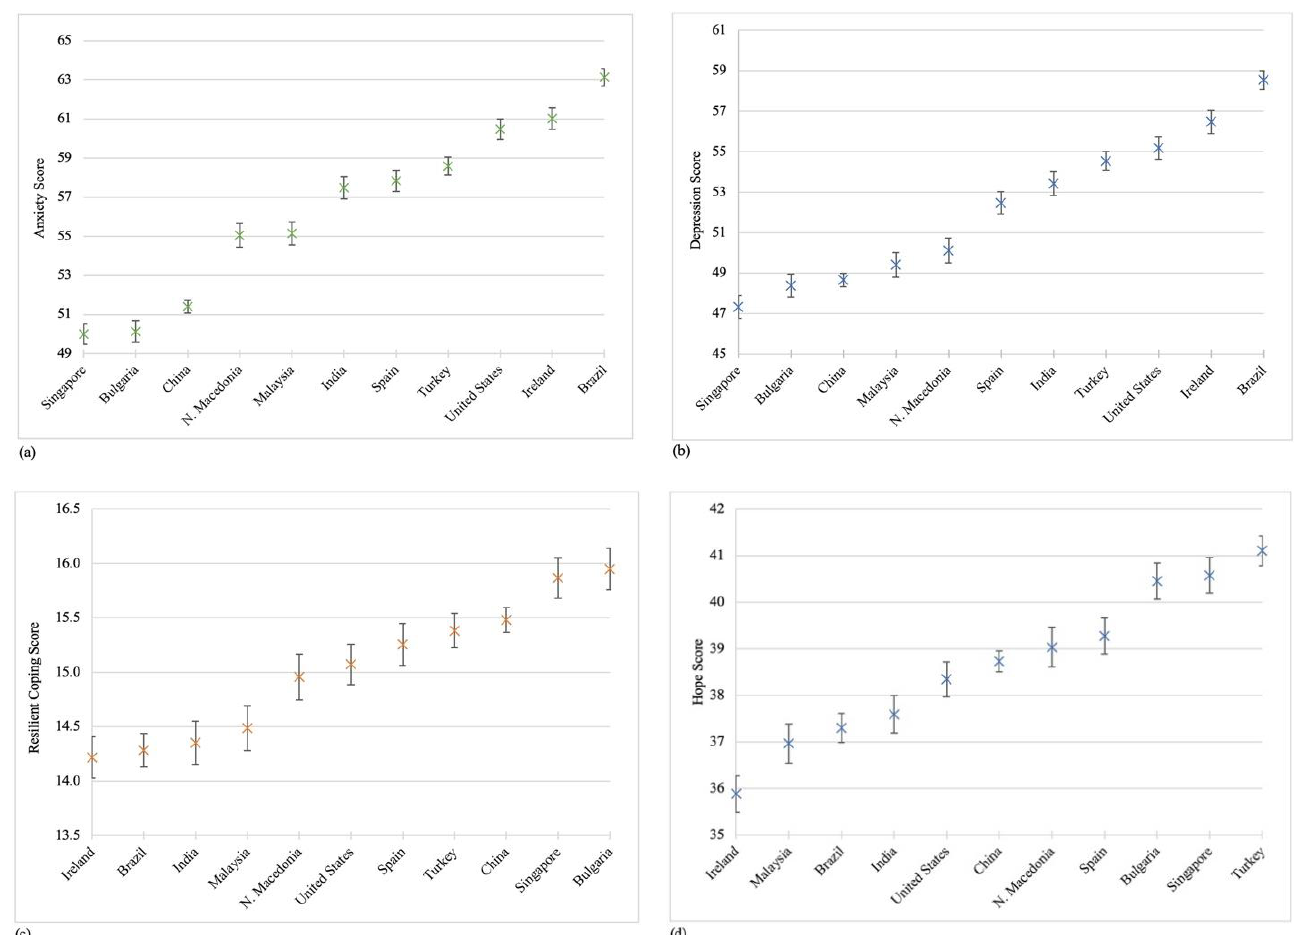
Figure 2. Mean scores of four mental health variables by participating countries: ( a ) Anxiety; ( b ) Depression; ( c ) Resilient Coping; ( d ) Hope. Note: p -values were based on Bonferroni post hoc tests accounting for multiple comparison following ANOVA. T-Score was used in the calculation of mean scores for anxiety and depression symptoms. The mean scores of four mental health variables (anxiety, depression, resilient coping, and hope) are displayed, along with 95% CIs, for each county from low to high. We only describe the statistically significant results when a country was compared to other